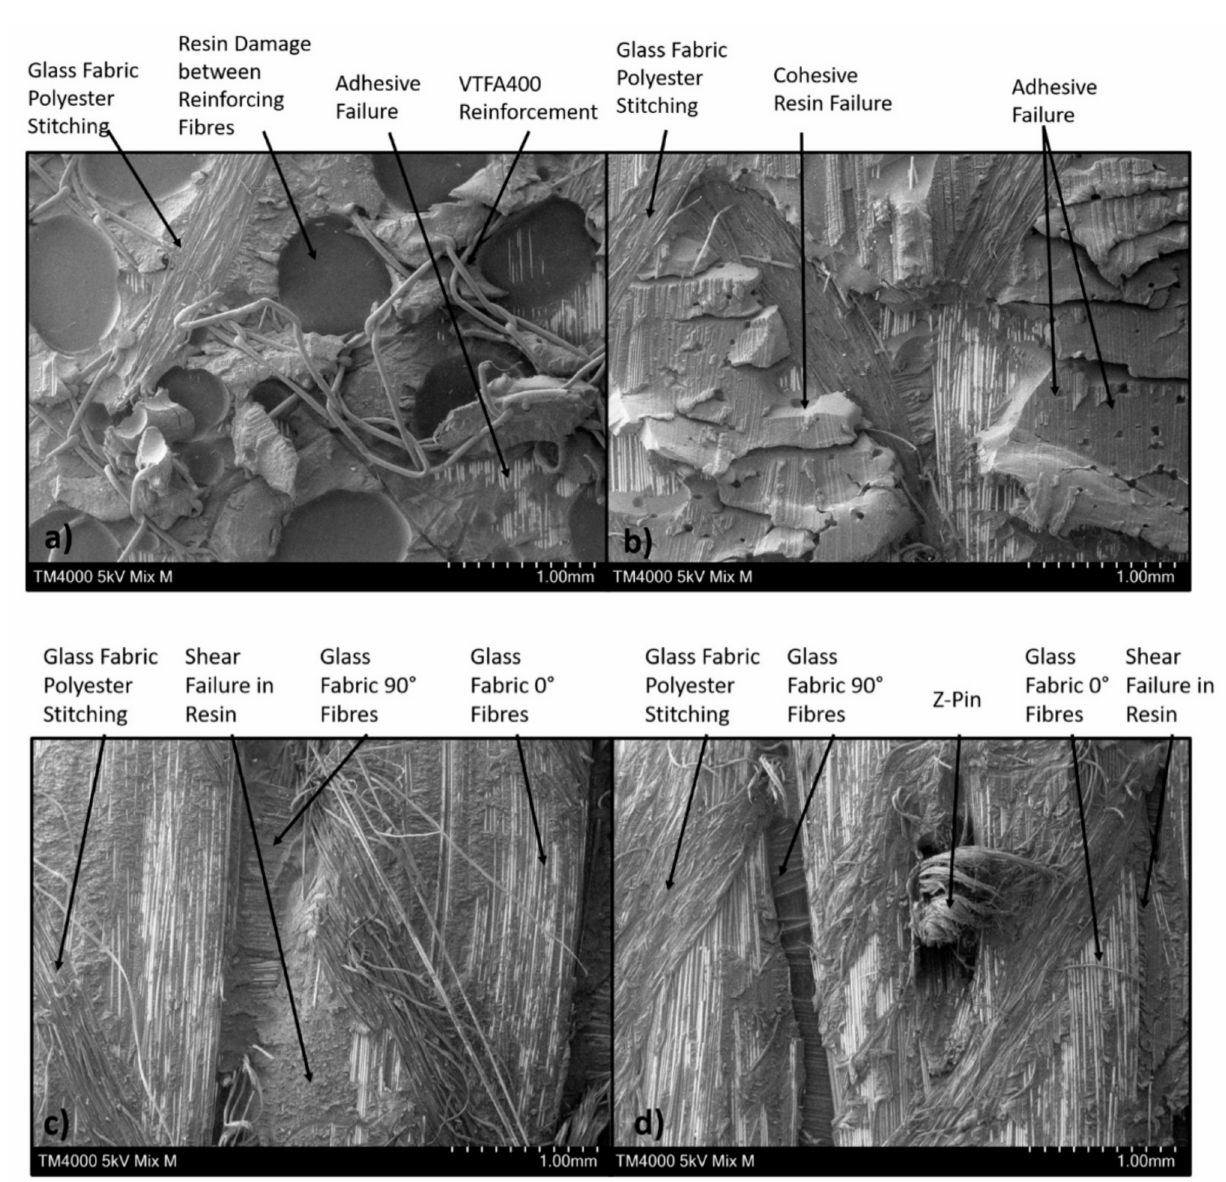
Figure 16. SEM Pictures of Fracture Surfaces with × 80 Zoom for ( a ) VTFA400 Specimens ( b ) Cured and Bonded with Powder Epoxy ( c ) Co-cured and ( d ) Co-cured and